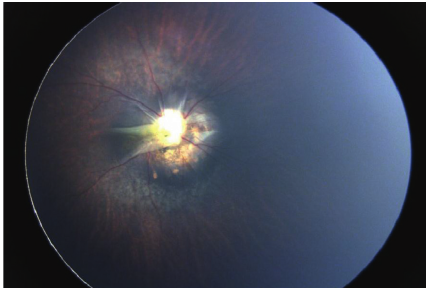
Figure 2: Fundus photography of the right eye. The photo shows mostly attenuated vessels, a small fibrous tuft of tissue originating from the optic disc, and a tessellated midperipheral